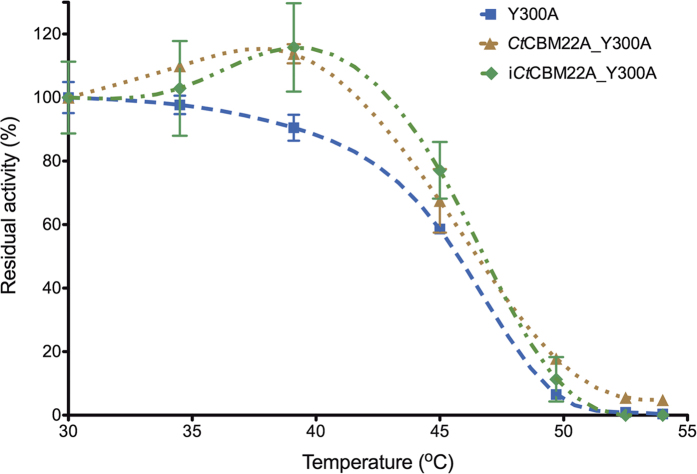
Thermostability of Y300A variants.Enzymes (16 nM) including OSX-immobilized CtCBM22A_Y300A (or iCtCBM22A_Y300A) were incubated at temperatures between 30 and 54 °C for 1 h, and residual activity was measured using 0.5 mM cellobiose.